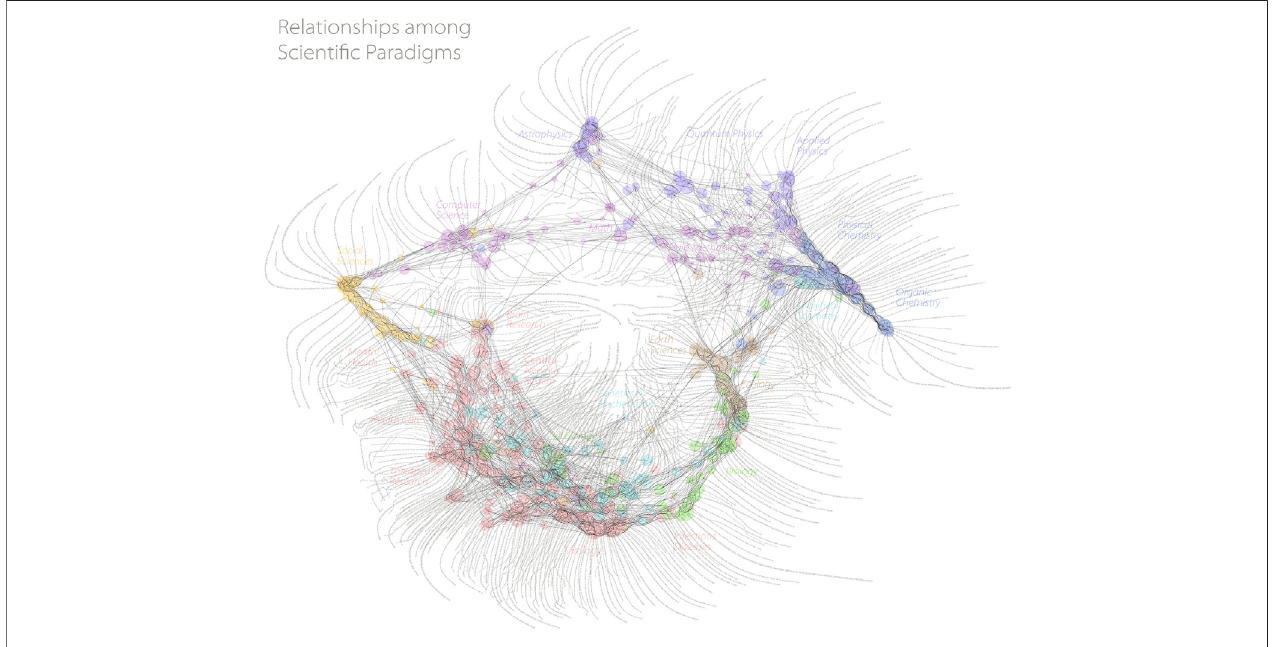
FIGURE 5 | One of the fi rst visualisations of research that made use of a full global dataset. While “ calculated ” , a signi fi cant amount of manual work was needed to make this beautiful visualisation, which ensures that detailed data is married with a meaningful visualisation. Reproduced with kind permission of W B Paley.